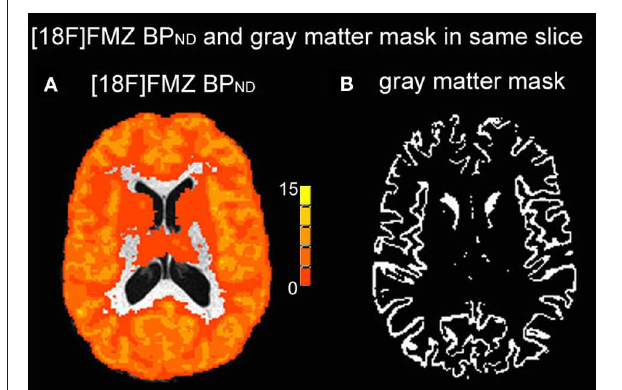
FIGURE 1 | (A) Example [ 18 F] FMZ BP ND image without partial volume correction (white matter as the reference region). (B) Example gray matter mask with a gray matter proportion threshold of 0.9 in the same slice as (A)